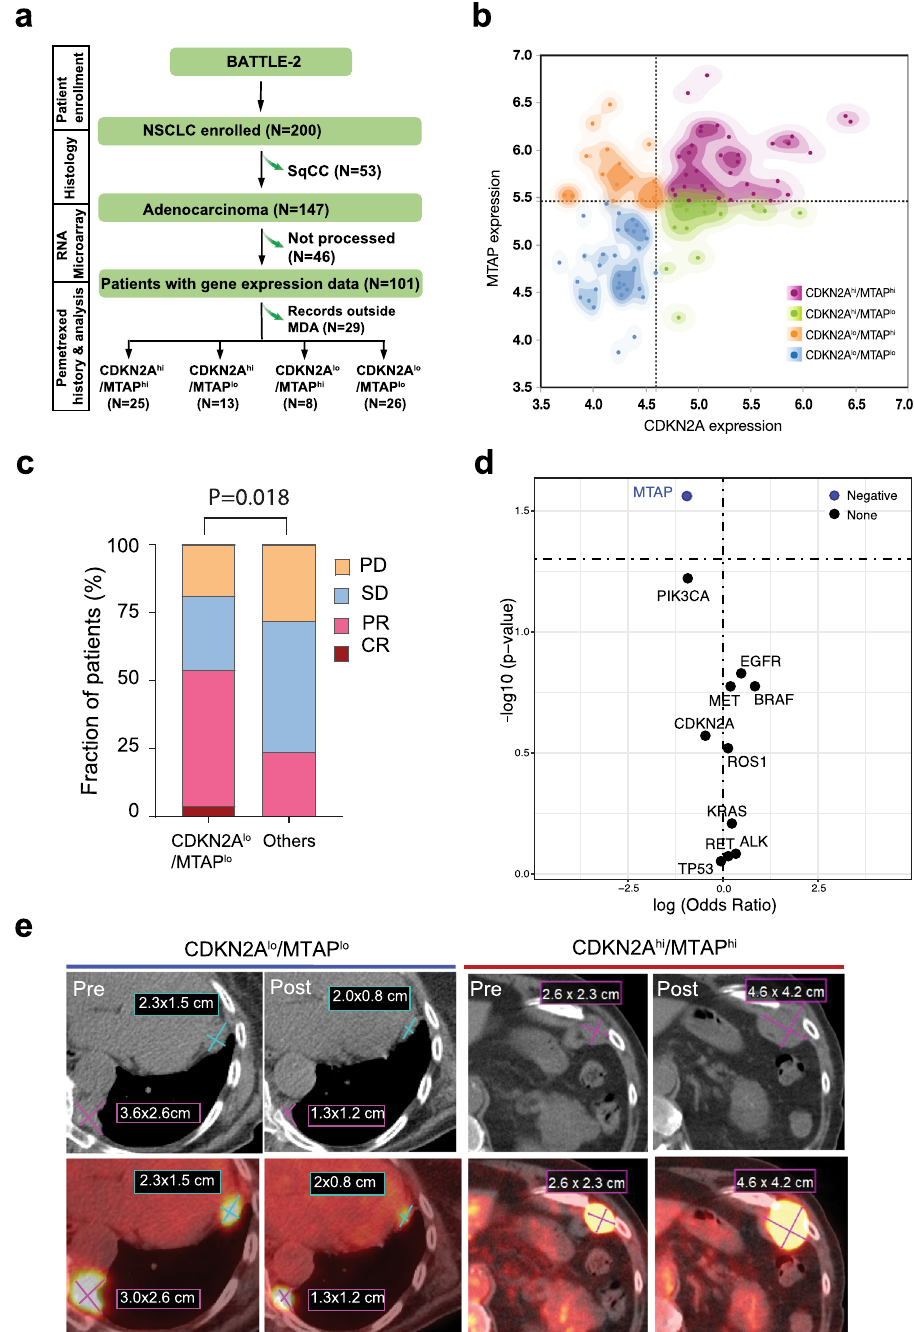
Fig. 4 MTAP de fi ciency leads increased sensitivity to folate-based therapy in lung adenocarcinoma. a Retrospective analysis schema for the BATTLE-2 trial. b Scatterplot of CDKN2A and MTAP RNA expression divided into four distinct groups with CDKN2A lo /MTAP lo and CDKN2A hi /MTAP hi having no overlap. MTAP cutoff value was 5.44 and CDKN2A cutoff value was 4.6 c Response rates to pemetrexed-based therapy in CDKN2A lo /MTAP lo vs all other groups. Difference is statistically signi fi cant by two-sided Fisher ’ s exact test ( p = 0.0115). d Generalized linear regression model evaluating the correlation of 10 most altered genes in lung cancer beside MTAP to estimate the odds ratio and p value for each gene independently. Genes with an odds ratio >1 (log (odds ratio) >0) and a p value <0.05 are considered to be positively correlated with response. Genes with an odds ratio <1 (log (odds ratio) <0) and a p value <0.05 are considered to be negatively correlated with response. Adjustments were made for multiple gene comparisons and q value are presented in supplementary table S5. e Example of a patient with metastatic CDKN2A lo /MTAP lo lung adenocarcinoma who partially responded to pemetrexed-based therapy compared to a patient with CDKN2A hi /MTAP hi lung adenocarcimoma who progressed after pemetrexed-based